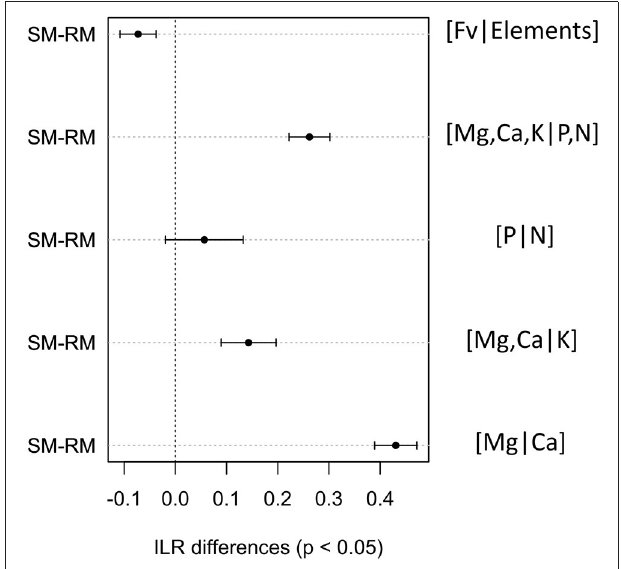
FIGURE 2 | Tukey tests determined differences in foliar ilr balances between sugar maple (SM) and red maple (RM) seedlings, as analyzed using a mixed model with plot and forest type as random factors. Differences are significant ( P < 0.05 ) when they do not include zero. Differences on the left side of the origin indicate that concentrations of nutrients in the left part of the balance are higher (or concentrations in right part lower) in SM than RM seedlings, and vice-versa.